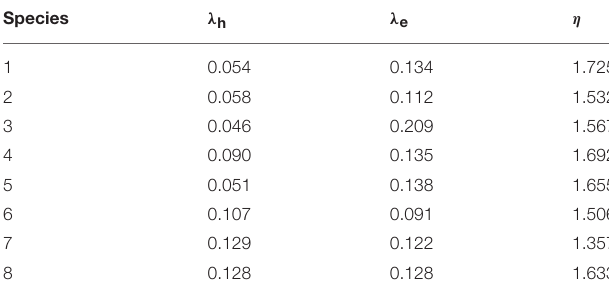
TABLE 5 | Calculated molecular λ e , λ h , and η (all in eV) of 1 – 8 at the PBE0/6-31G(d,p) level. Species λ h λ